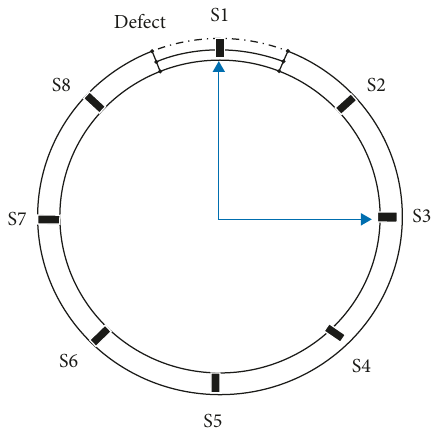
Figure 21: Receiving point